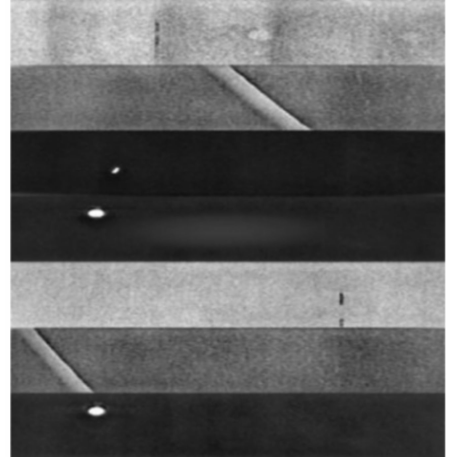
Figure 9. Examples of the collected